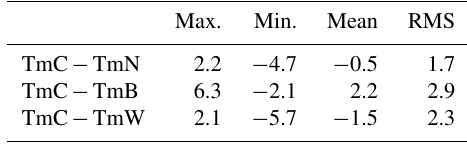
Table 1. Summary of the T m deviation between COSMIC-derived and model-derived ( K ) data.